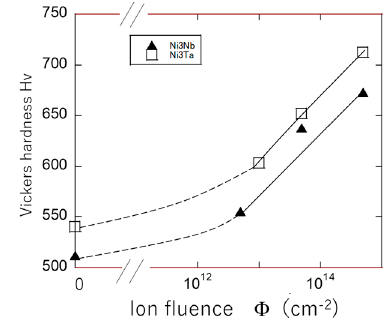
Figure 26. Vickers hardness as a function of 16 MeV Au ion fluence for Ni 3 Nb and Ni 3 Ta.